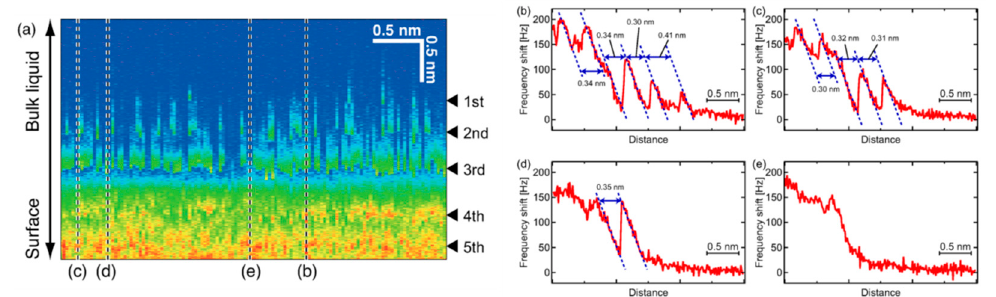
Figure 18. Frequency modulation (FM)-AFM investigation of the [Py 1,4 ][FAP]/KCl(100) interface. ( a ) Frequency shift–distance curves measured along a distance of 4 nm; ( b – e ) cross-sections obtained at the lines marked in ( a ). Adapted with permission from Ichii et al. [125]. Copyright 2014, the American Chemical Society.